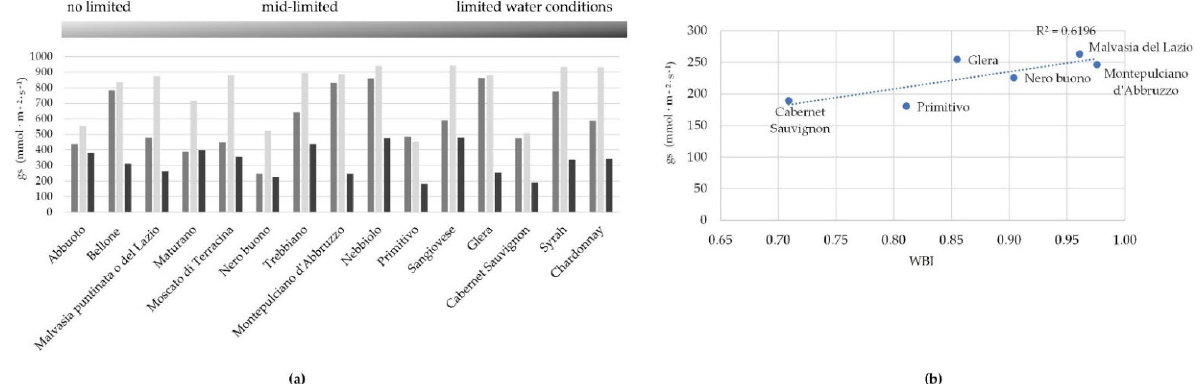
Figure 4. Stomatal conductance under different limited water conditions ( a ); relationship with water band index (WBI) for “water saving” genotypes ( b ). Data refer to the measure at BBCH 091 (after harvest–end of wood maturation).